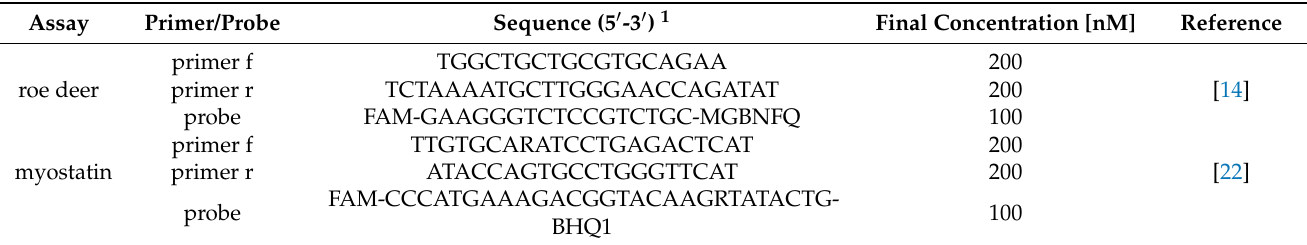
Table 2. Primers and